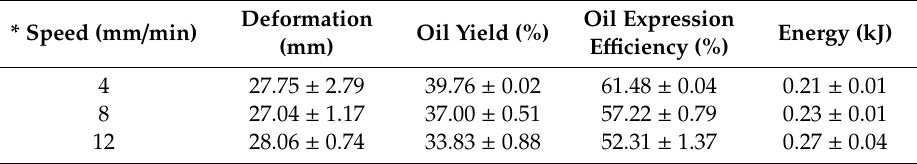
Table 1. E ff ect of speed on deformation, oil yield, oil expression e ffi ciency, and energy.